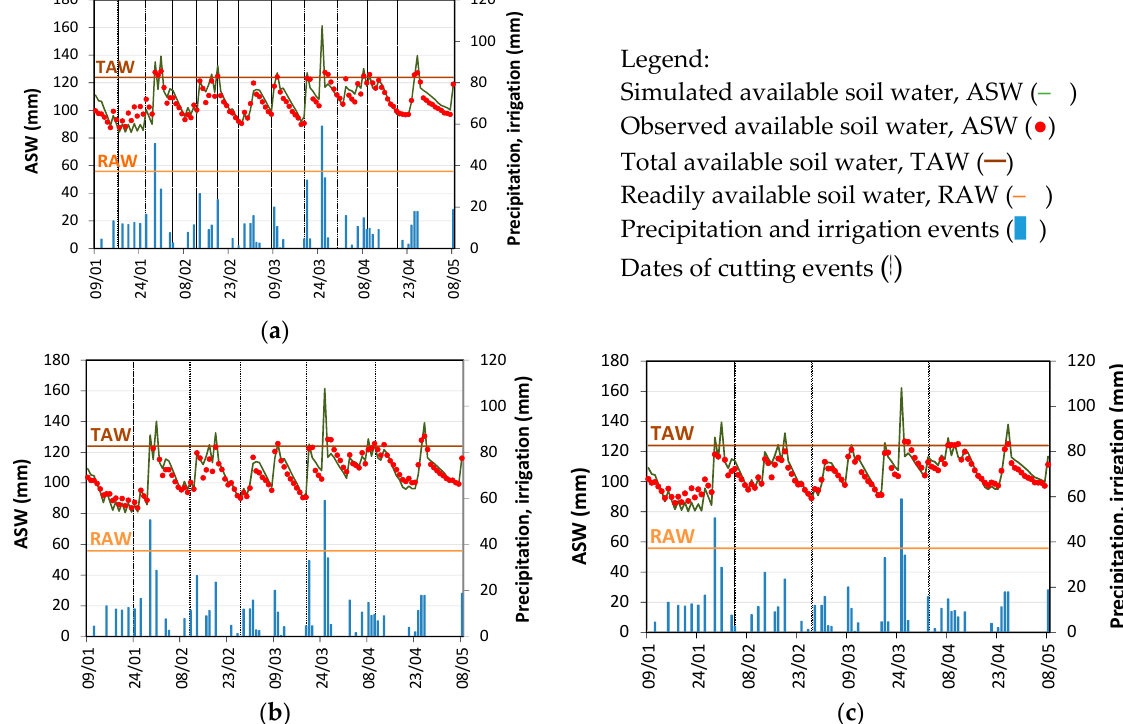
Figure 2. Simulated vs. observed available soil water during the Summer-Autumn of 2016 relative to the calibration of SIMDualKc model for treatments of CGDD of: ( a ) 124 ° C, ( b ) 248 ° C and ( c ) 372 ° C.